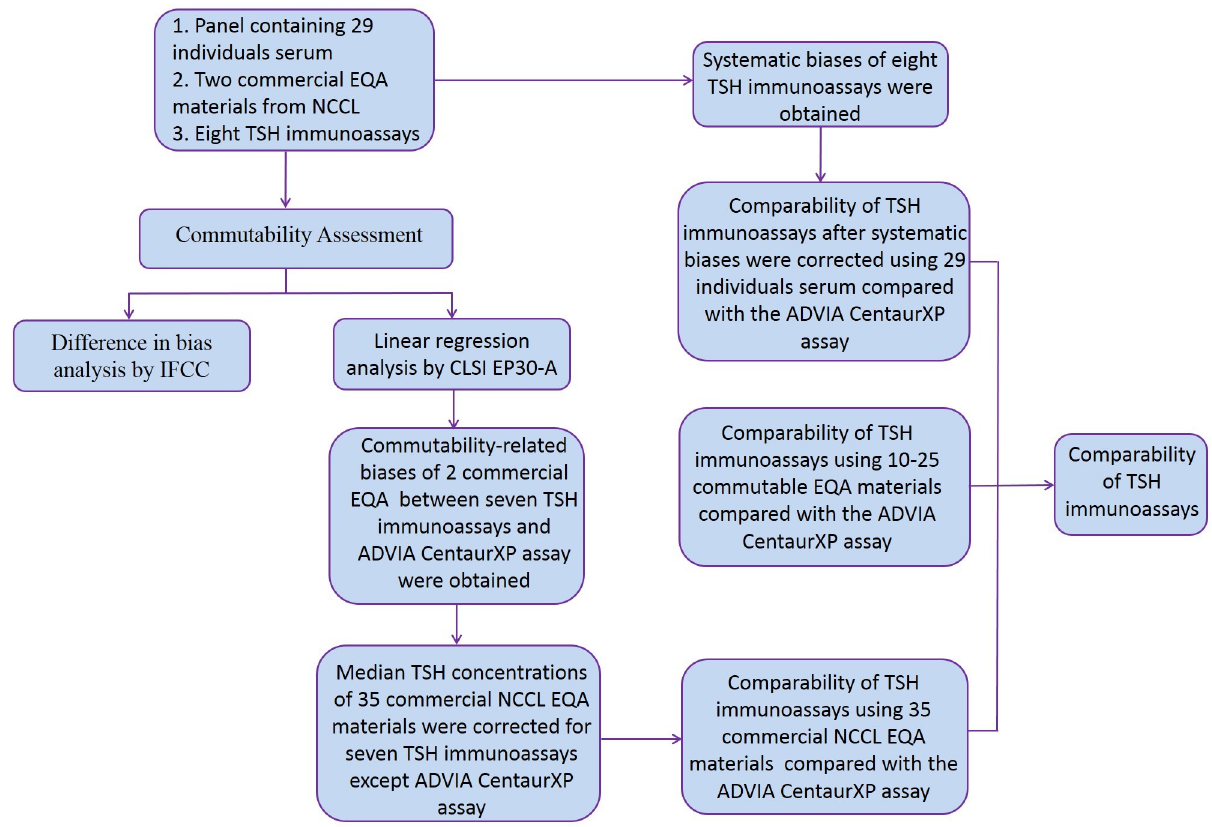
Fig 1. A workflow chart demonstrating the comparability of eight TSH immunoassays using three methods.